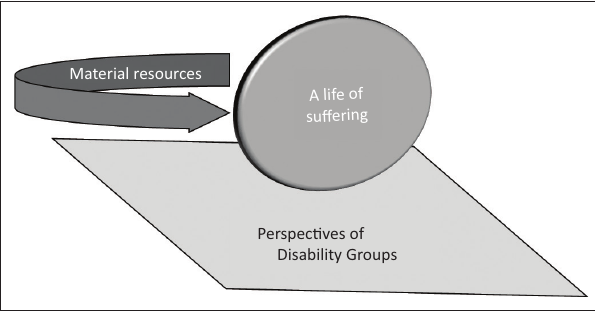
FIGURE 1: Poverty conceptualised as a two-sided